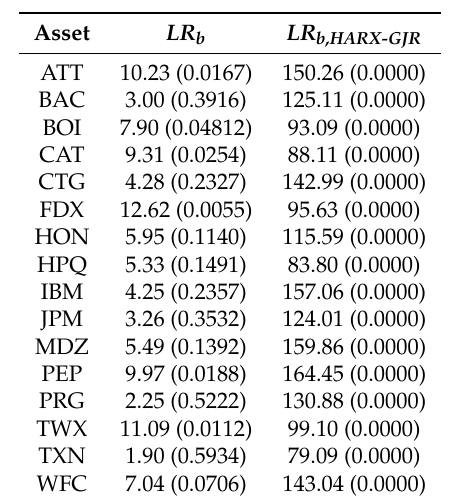
Table 4. Berkowitz test for the single asset